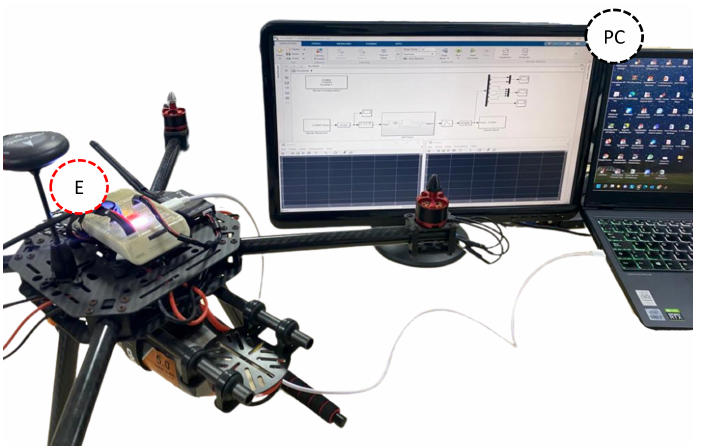
Figure 8. Components of the HIL simulation: the embedded system (E) and the personal com- puter (PC).